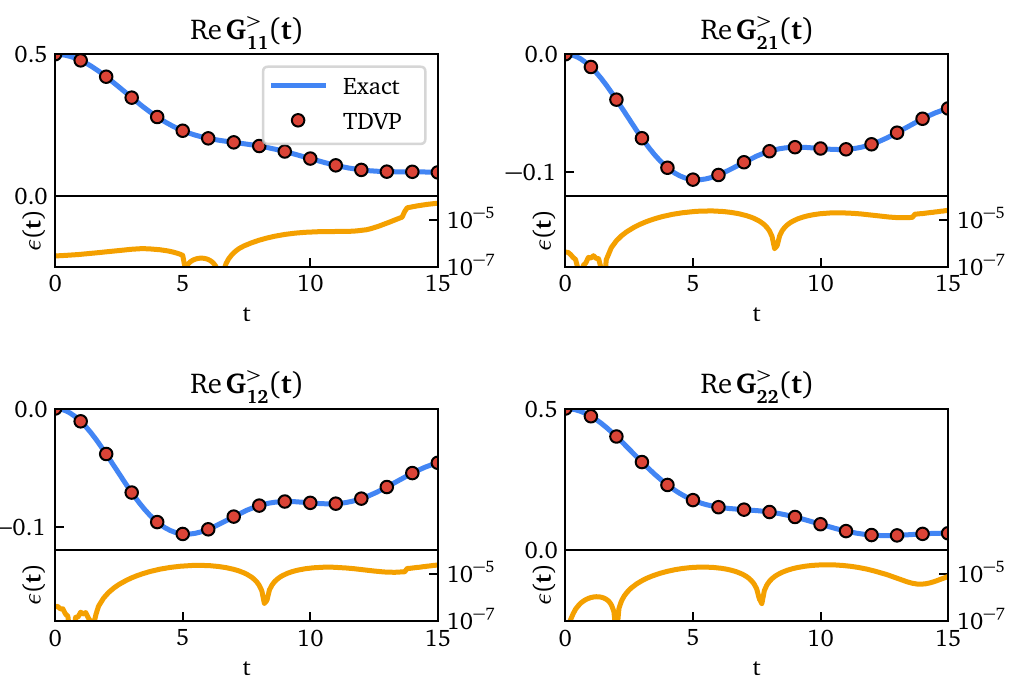
( t ) for a two-orbital Figure 11: Comparison of impurity greater Greens function G > ll (cid:48) model between TDVP and the exact solution. In each segment, the top panel shows the Green’s function itself, while the bottom panel shows the absolute value of the ( t ) − G > ( t ) | , i.e., the numerical error. We obtained the difference ε ( t ) = | G > exact TDVP exact solution from diagonalization of the hopping matrix at U = J = 0. The calcu- lation was performed for a spin-degenerate model using 9 bath sites per orbital and spin. We allowed off-diagonal hopping terms only between the orbital degrees of [ k ] [ k ] = δ = δ freedom, i.e., V and therefore G ( σσ (cid:48) V σσ (cid:48) G mm (cid:48) . The pa- m σ )( m (cid:48) σ (cid:48) ) ( m σ )( m (cid:48) σ (cid:48) ) mm (cid:48) = − 0.8, − 0.6, ··· ,0.6,0.8 for all orbitals, diagonal hybridizations rameters were ε k = 0.1 ∀ k , l and off-diagonal hybridizations V [ k ] = 0.05 ∀ k for m = 2, m (cid:48) = 1. V [ k ] mm mm (cid:48) These off-diagonal terms correspond to a hopping processes from the impurity of orbital 2 to the bath of orbital 1. The TDVP time step was chosen ∆ t = 0.1 and = 0. Note that the off-diagonal hybridizations break the on-site energies were ε m σ 0 orbital degeneracy, albeit for the parameters chosen only slightly and the differences between the two orbitals are barely visible. Truncated weight (sum of all truncated Schmidt values) during DMRG and the time evolution was 10 − 9 , except during the time evolution of the impurity impurity links where no truncation was performed. During DMRG as well as time evolution, the impurity-impurity links were restricted to